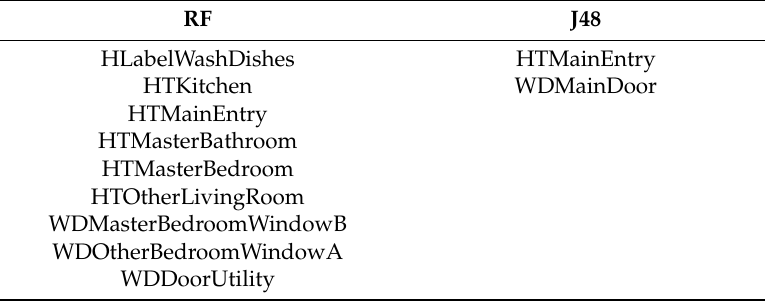
Table 10. Selected SH attributes that as a group predict indoor formaldehyde in IAQ 2 .